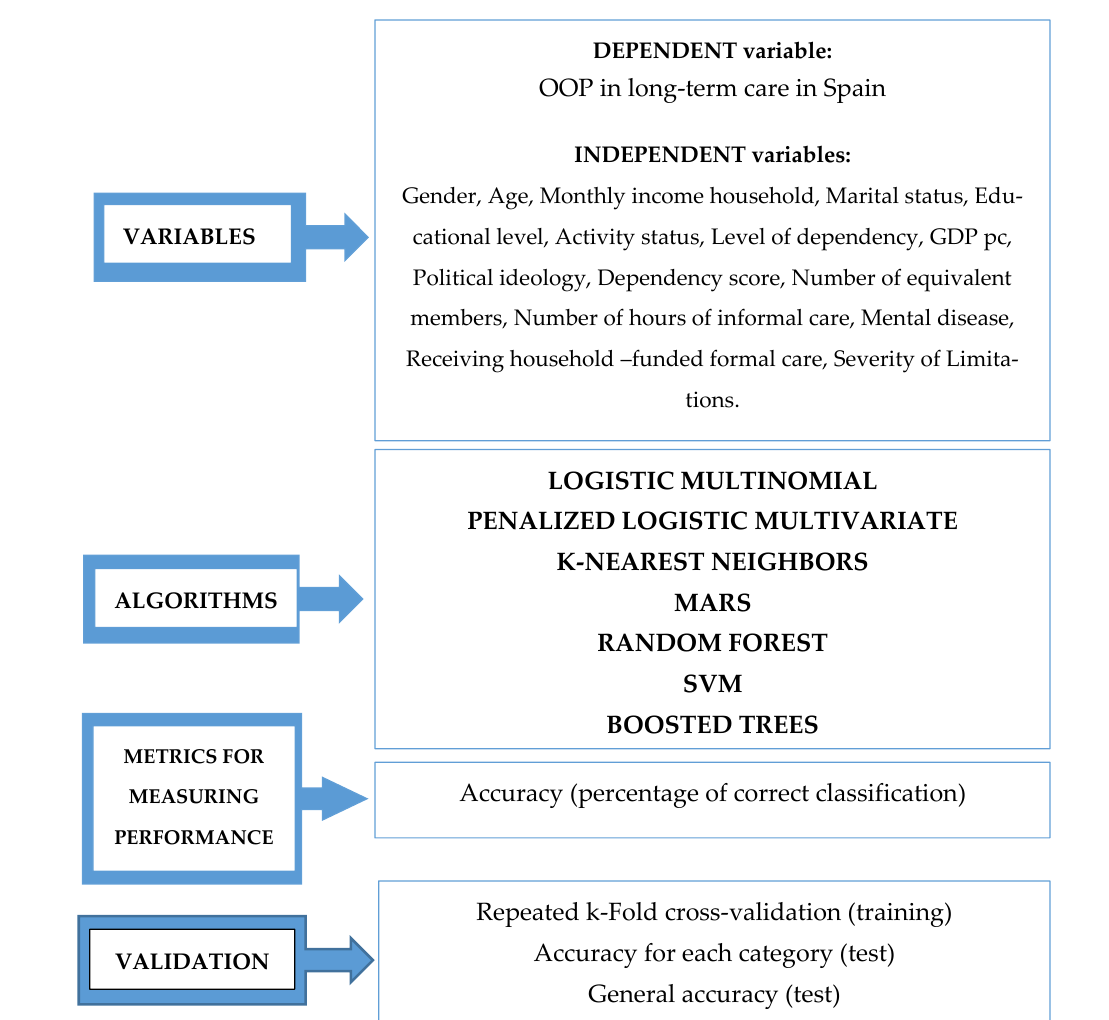
Figure 1. General outline of the process.